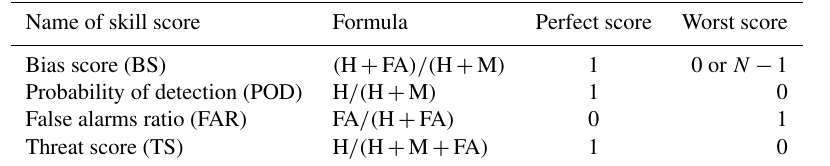
Table 2. List of the categorical skill scores and their